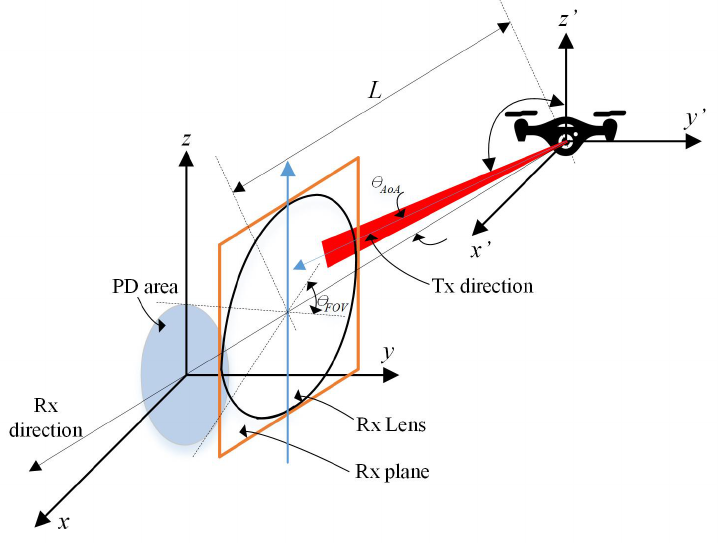
Figure 2. Modeling of the received beam at the FSO Rx station in the presence of UAV’s